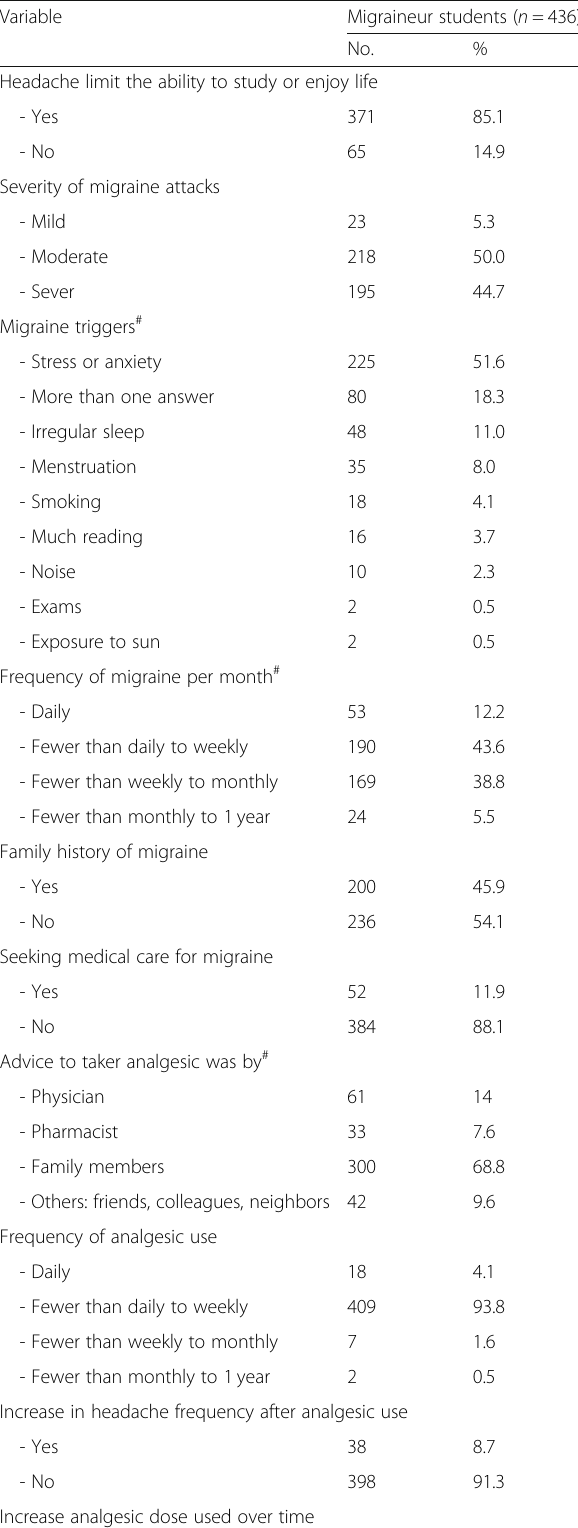
Table 2 Distribution of migraineurs according to